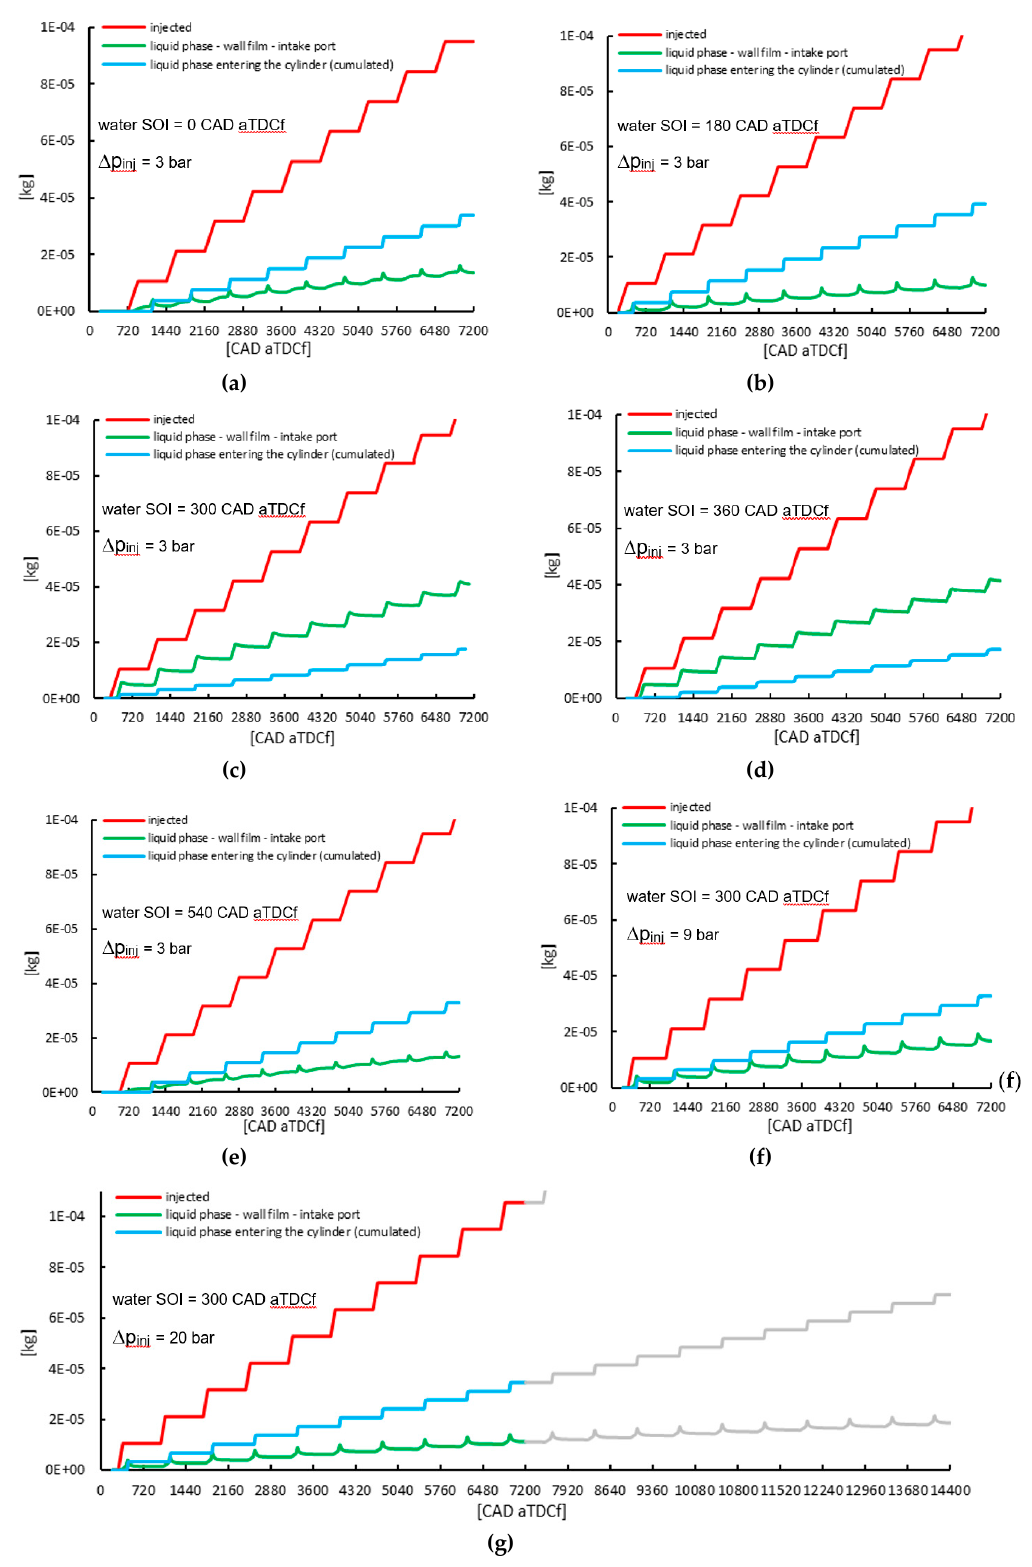
Figure 7. Dynamics of liquid water in the ports and runner, for each simulated case. ( a ) 3 bar—SOI = 0 CAD aTDCf; ( b ) 3 bar—SOI = 180 CAD aTDCf; ( c ) 3 bar—SOI = 300 CAD aTDCf; ( d ) 3 bar—SOI = 360 CAD aTDCf; ( e ) 3 bar—SOI = 540 CAD aTDCf; ( f ) 9 bar—SOI = 300 CAD aTDCf; ( g ) 20 bar—SOI = 300 CAD aTDCf.